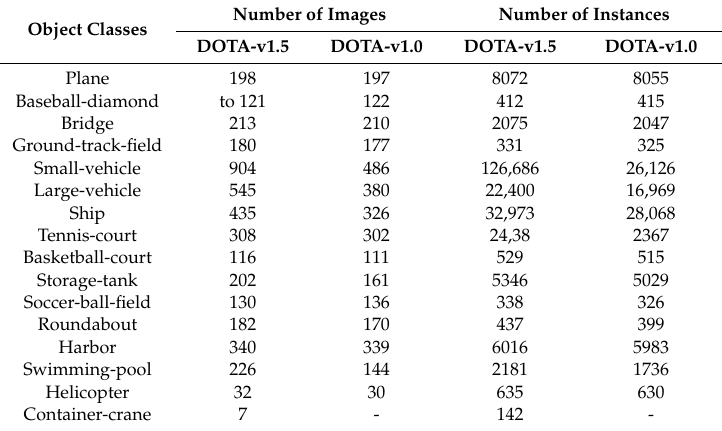
Table 1. Analysis results of the training part of the DOTA-v1.5 and DOTA-v1.0 dataset. The number of images in this table is not the actual number of images, because one image may contain more than one